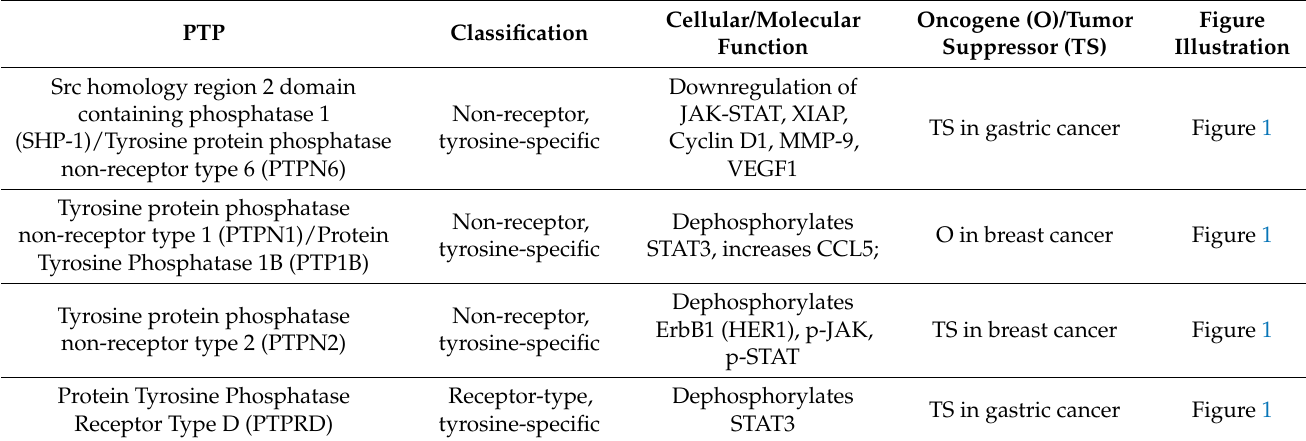
Figure 1. PTPs that regulate the JAK-STAT pathway. The mechanism of some PTPs influence the JAK-STAT or STAT- CCL5 pathway. For a more in-depth discussion of the mechanism of action for each PTP, refer to Table 1. Adapted from “Cytokine Signaling through the JAK-STAT Pathway”, by BioRender.com (accessed on 28 September 2021). Retrieved from https://app.biorender.com/biorender-templates (accessed on 28 September 2021). Table 1. PTPs that regulate the JAK-STAT